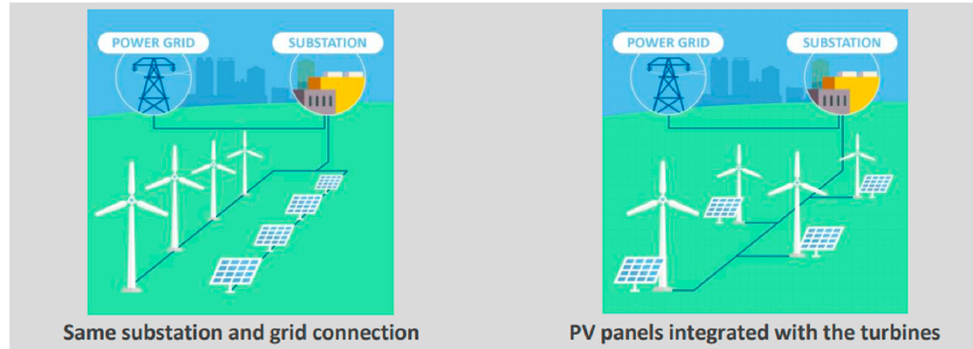
Figure 8. Common types of HPPs [1].